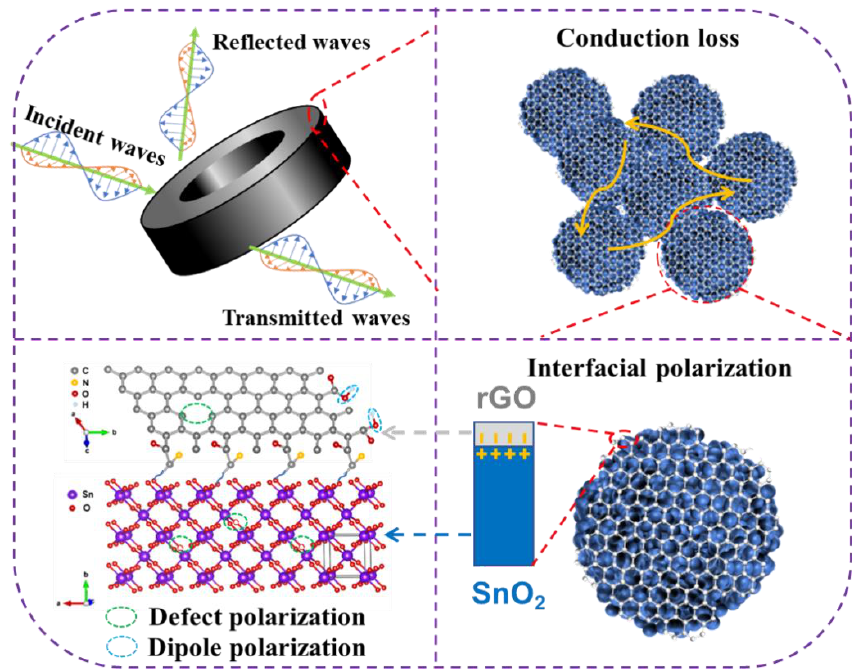
Figure 9. Schematic diagram of multiple EMW absorption mechanisms in SnO 2 @rGO composites.